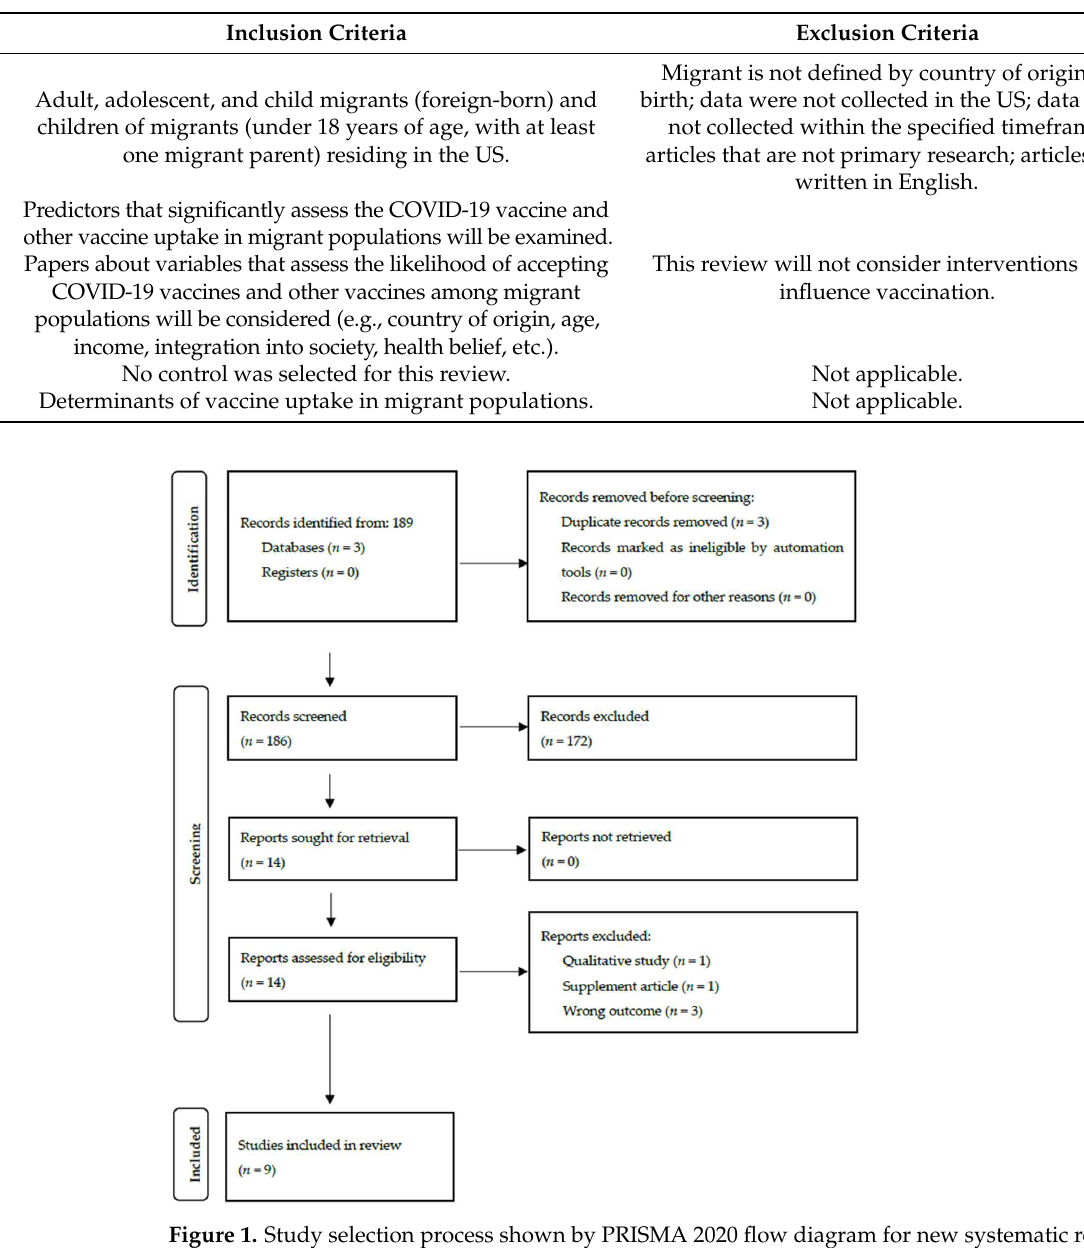
Table 1. Inclusion and exclusion criteria using PICOS framework.